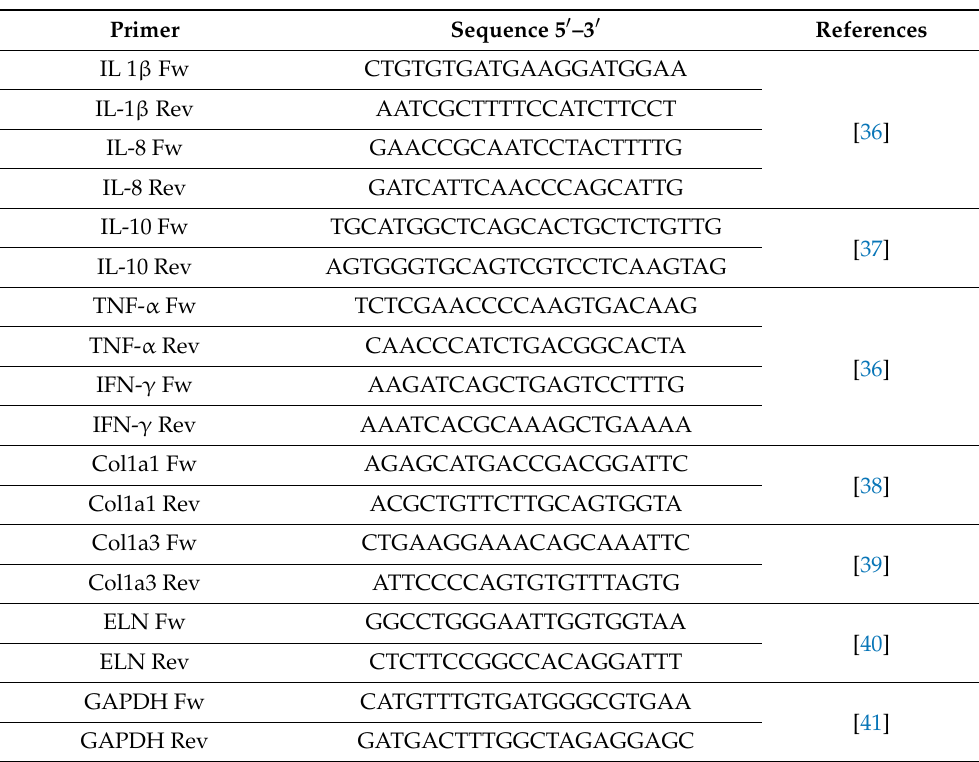
Table 2. List of primers used in qRT-PCR for target genes mRNA of dog. Primer Sequence 5 (cid:48) –3